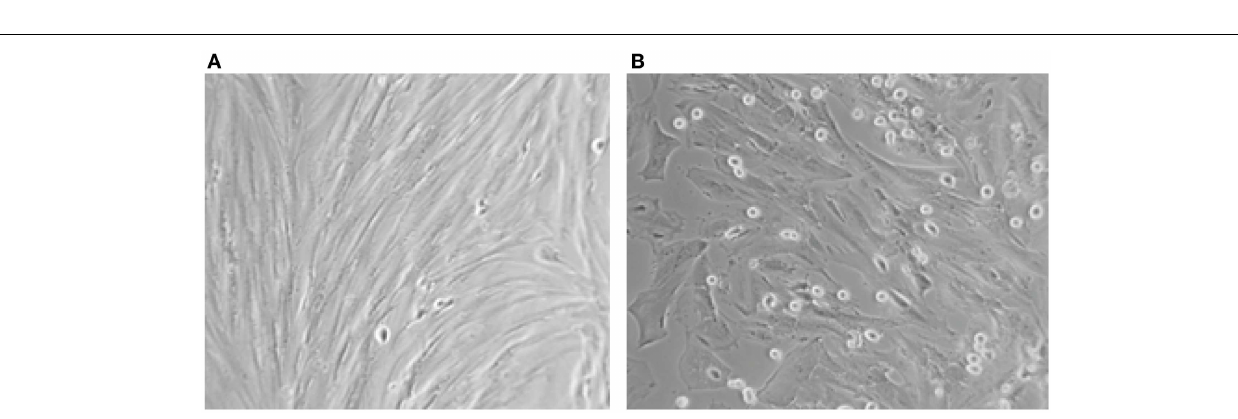
FIGURE 3 |Aspect on phase contrast microscopy of untreated (A) and endometriotic cells treated with 2-Ethoxyestradiol (1mM) during 24h (B) . A striking morphological change was obtained after 12h of treatment.The 2-Ethoxyestradiol induced decrease of DNA synthesis by 68% after 48h of treatment (BrDU